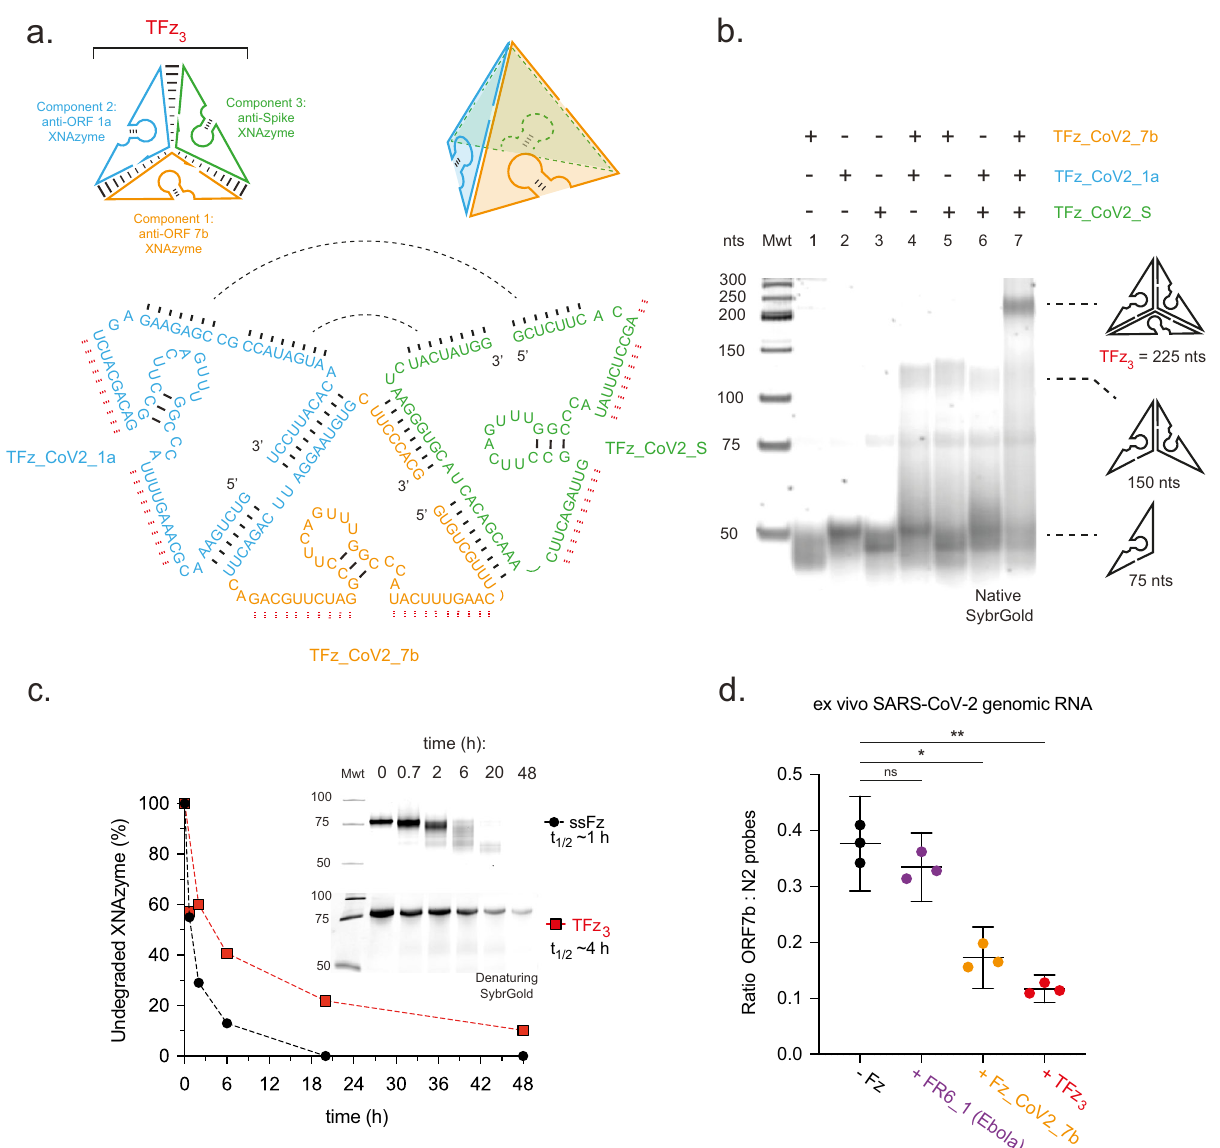
Fig. 2 | Assembling XNAzymes into a catalytic XNA nanostructure improves biostability whilst retaining the ability to cleave the genome of SARS-CoV-2. a Schematics showing the design of a three-component fully-FANA nanostructure ( ’ TFz 3 ’ ) presenting three different SARS-CoV-2 XNAzymes (Fz_CoV2_7b, Fz_CoV2_S and Fz_CoV2_1a) along single-stranded edges (strand hybridisation is designed to be mediated by base pairing indicated by black lines; red lines indicate residues mediating SARS-CoV-2 RNA substrate binding). b Native PAGE gel showing self- assembly of the complete TFz 3 nanostructure is dependent on all three compo- nents. c Urea-PAGE gels and graph showing the stability of the puri fi ed, fully- assembledTFz 3 (redsquares)orasingle-strandedcomponent( ’ ssFz ’ :TFz_CoV2_7b) (blackcircles)in50%humanserumat37°C. d Quanti fi cationofcleavageofexvivo